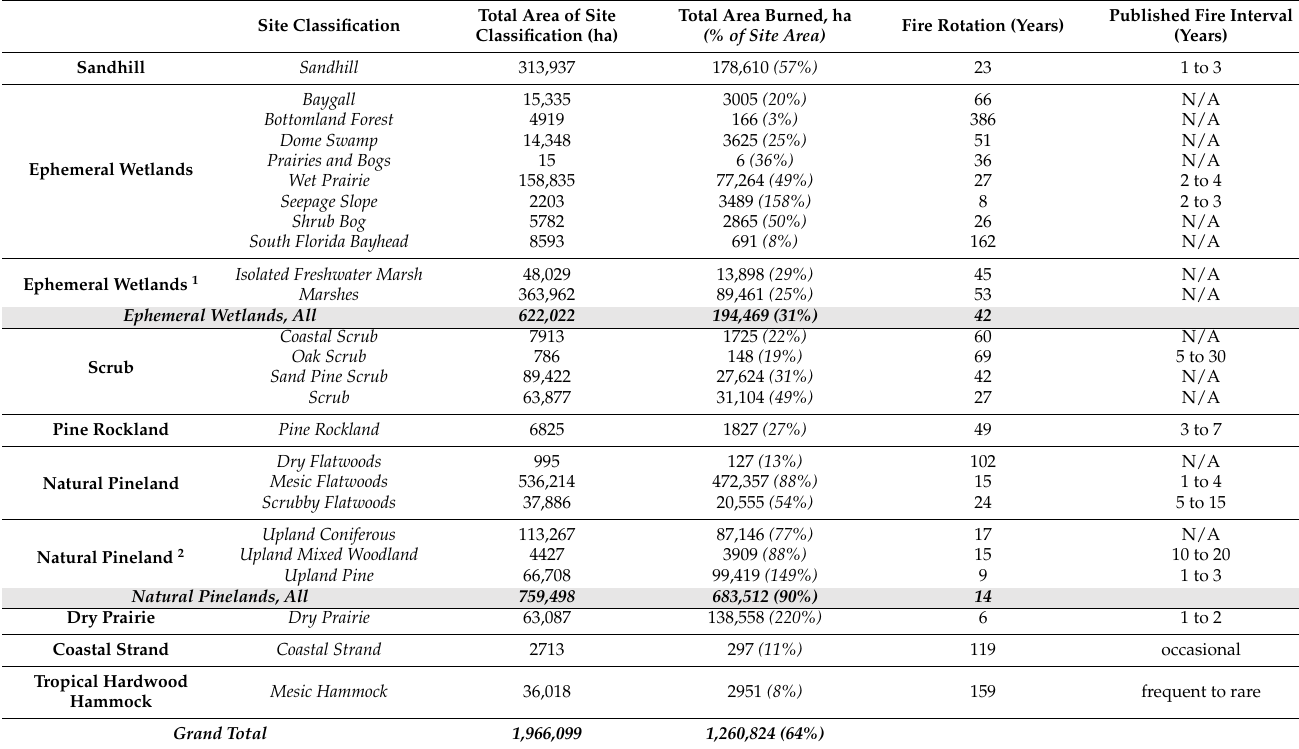
Table 2. Total hectares burned within the state of Florida for specific habitats of interest (based on Cooperative Land Cover Site Classification v3.2.2; [51]). These values were derived from burned area produced by thresholding the Landsat burn probability product ( ≥ 90%) occurring solely in the state, based on 13 years of data (2006–2018). Fire rotations [46] are compared to published fire interval values [39] for these systems.